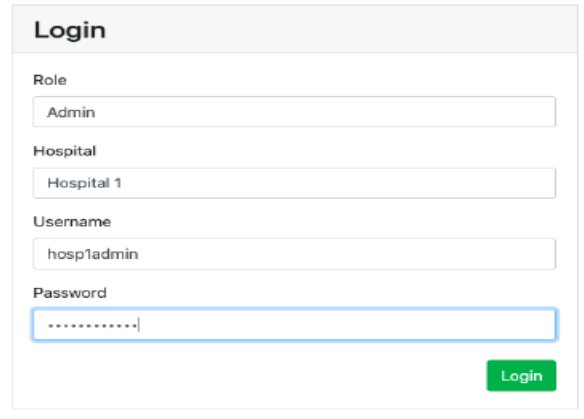
Figure 8. Admin login.